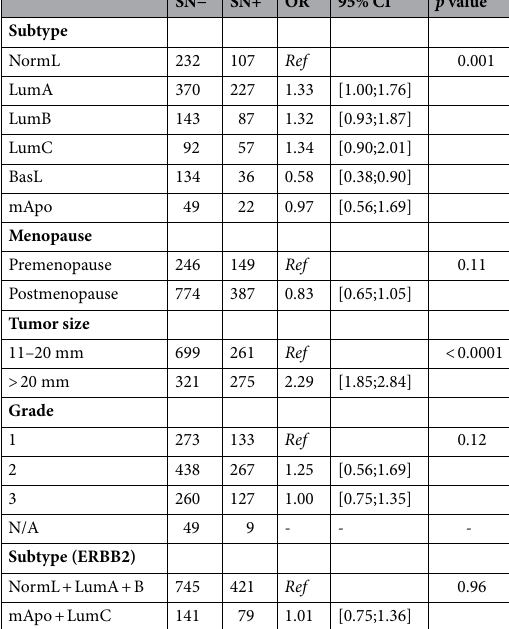
Table 2. Univariate logistic regressions comparing subtypes or clinicopathological features across subtypes. The odds ratio (OR) and 95% confidence interval (CI) for SN + vs. SN − is presented for each group compared to a reference ( Ref ). p values represent those of the χ 2 test across all categories excluding